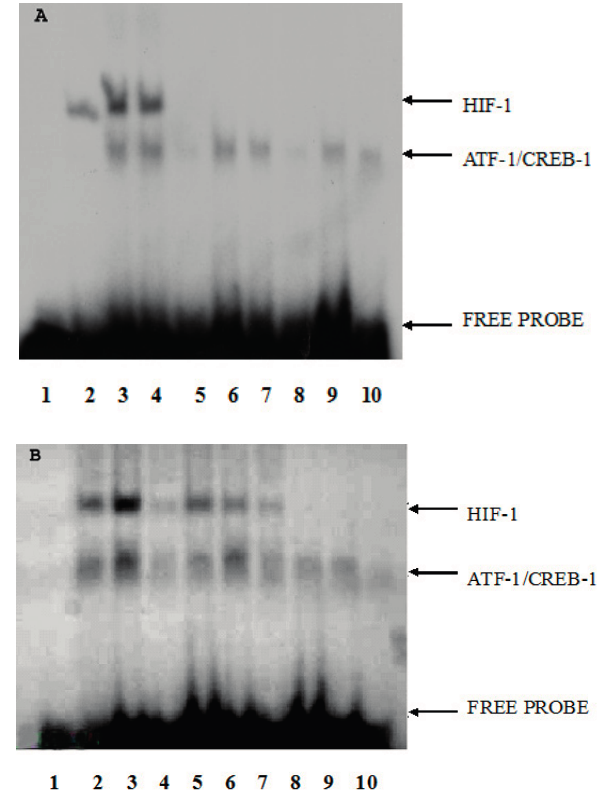
Figure 3. DNA-binding activity of HIF-1 on the EPO hypoxia response element (HRE) in hippocampus of mice in different groups. Lane 1: protein free. EMSA using crude